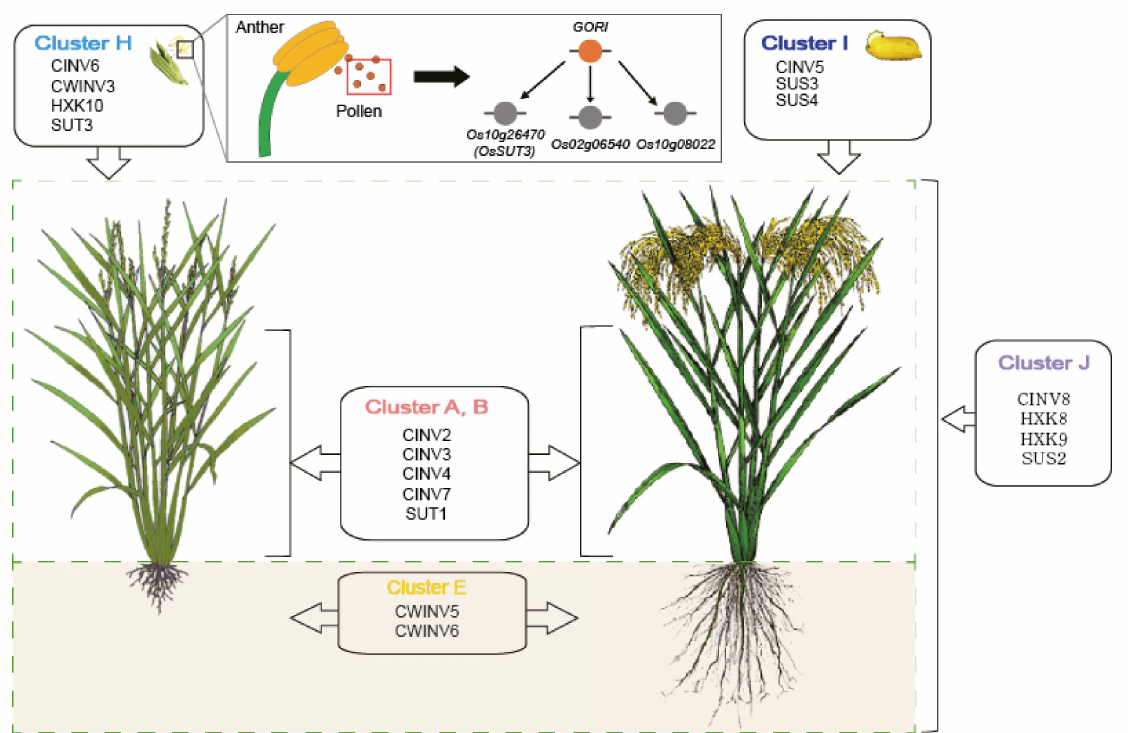
Figure 5. Conceptual carbohydrate model integrated with cluster information. A conceptual model was constructed by summarizing dissected carbohydrate metabolism-related genes according to the anatomical expression pattern. This model indicates the clusters associated with key enzymes (INVs, SUTs, SUSs, and HXKs) for source-sink communication. Clusters A and B are associated with leaf and flag leaf, cluster E is associated with root, cluster H is associated with anther and pollen, cluster I is associated with grain, and cluster J is associated with the whole rice plant based on ubiquitous expression patterns. The GORI regulatory model for pollen tissue was also